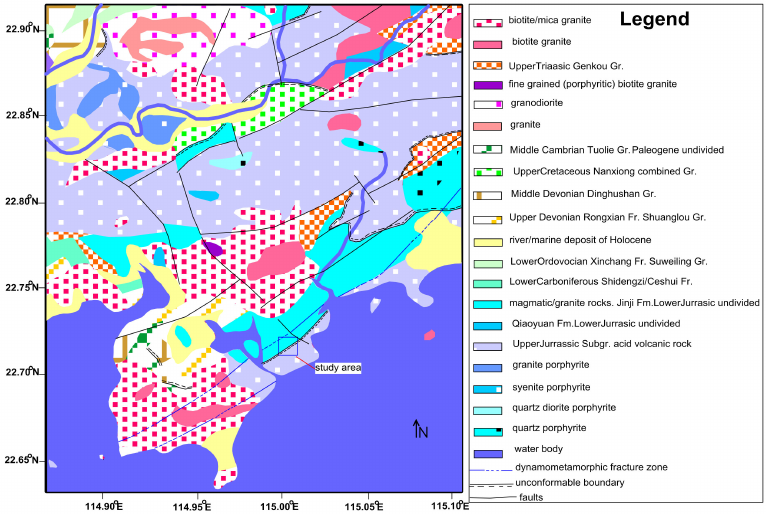
Figure 2. Hydrogeological map of the study area (modified after [41]).